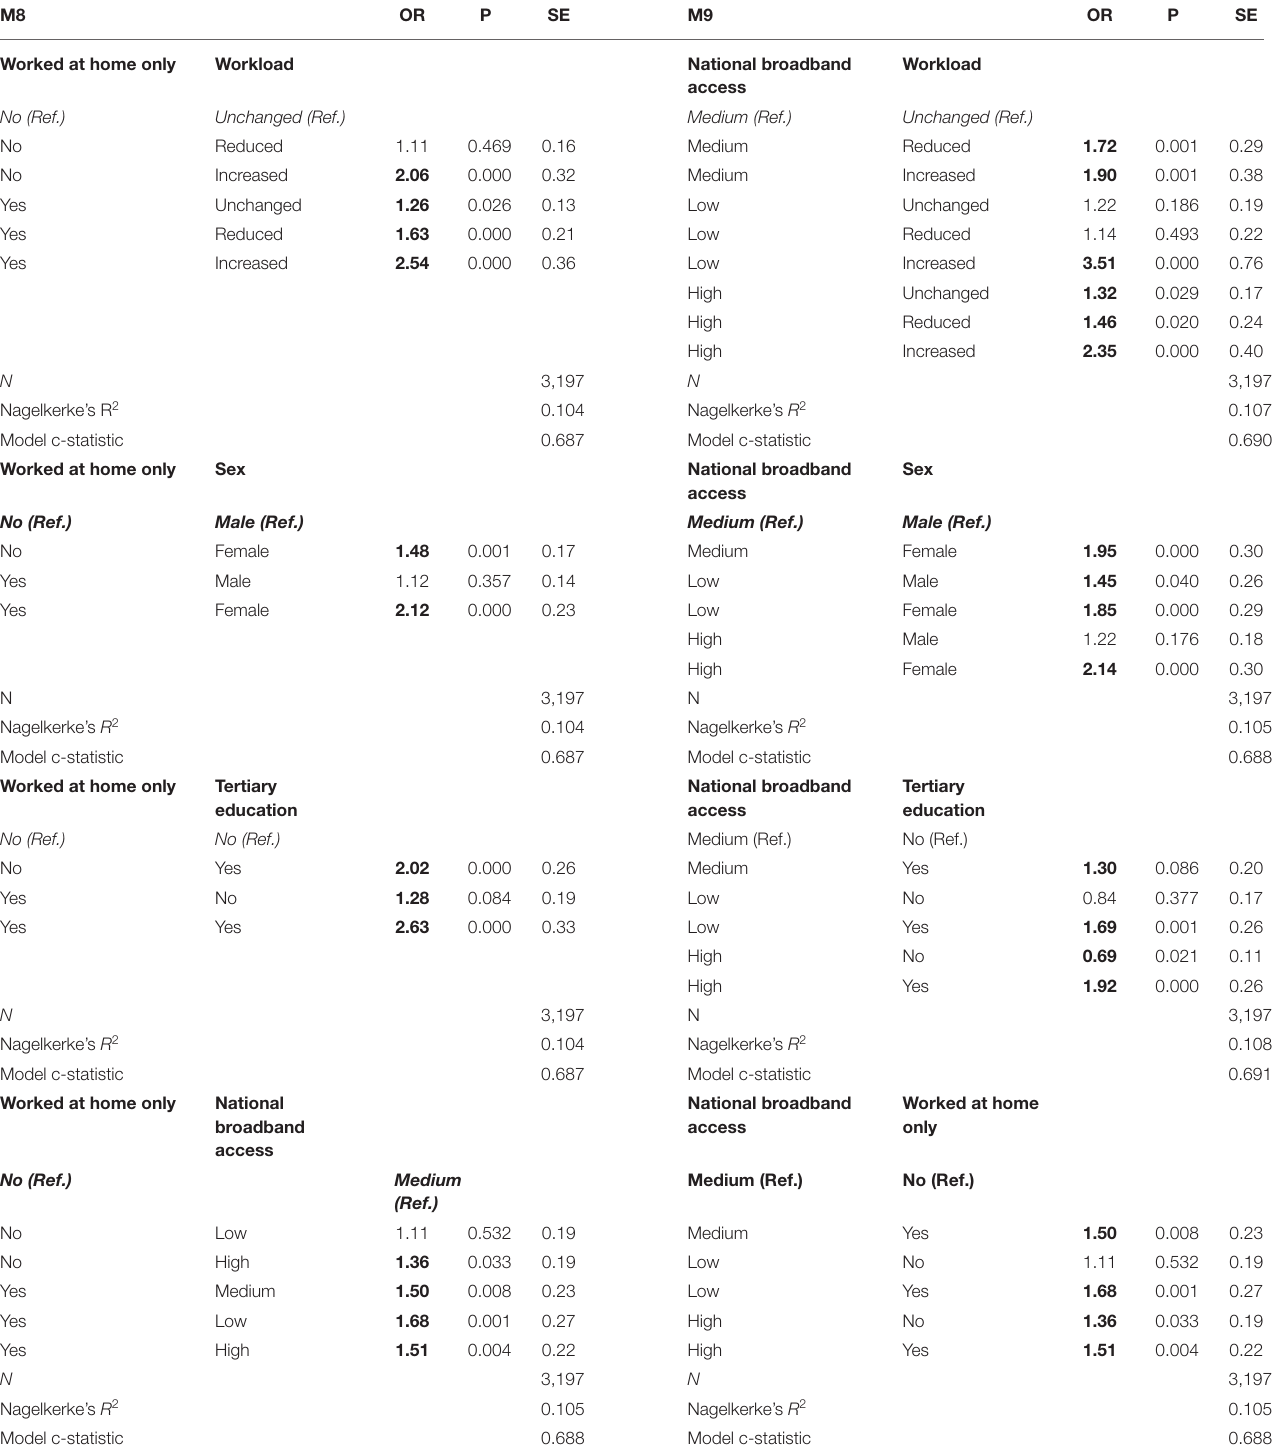
TABLE 3 | Interactions between determinants of improved computer skills. M8 Worked at home